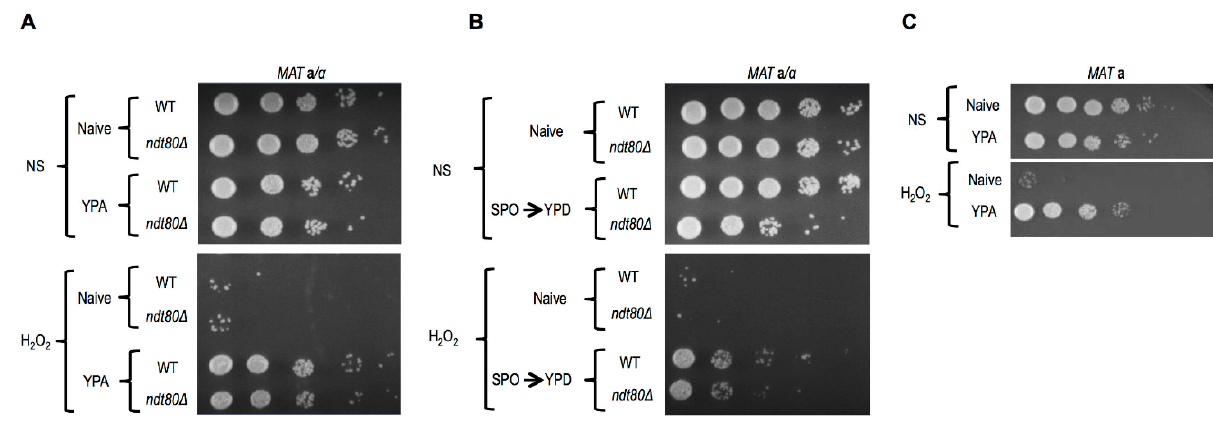
FIGURE 3: YPA media induced acquired stress resistance. (A) WT or ndt80 ∆ / ∆ a/alpha diploid cells were grown in YPA media and subjected to H 2 O 2 stress. 10-fold serial dilution spot assay of Naïve or YPA grown cells are shown. (B) WT and ndt80 ∆ / ∆ strains were incubated in spor- ulation media to induce spore formation or meiotic arrest respectively. Following dilution of these cells into YPD and incubation for 5 hours (SPO →YPD), resistance to H 2 O 2 was assayed using spotting tests. (C) 10-fold serial dilution spot assay of haploid cells grown in YPA media subjected to H 2 O 2 stress or not is